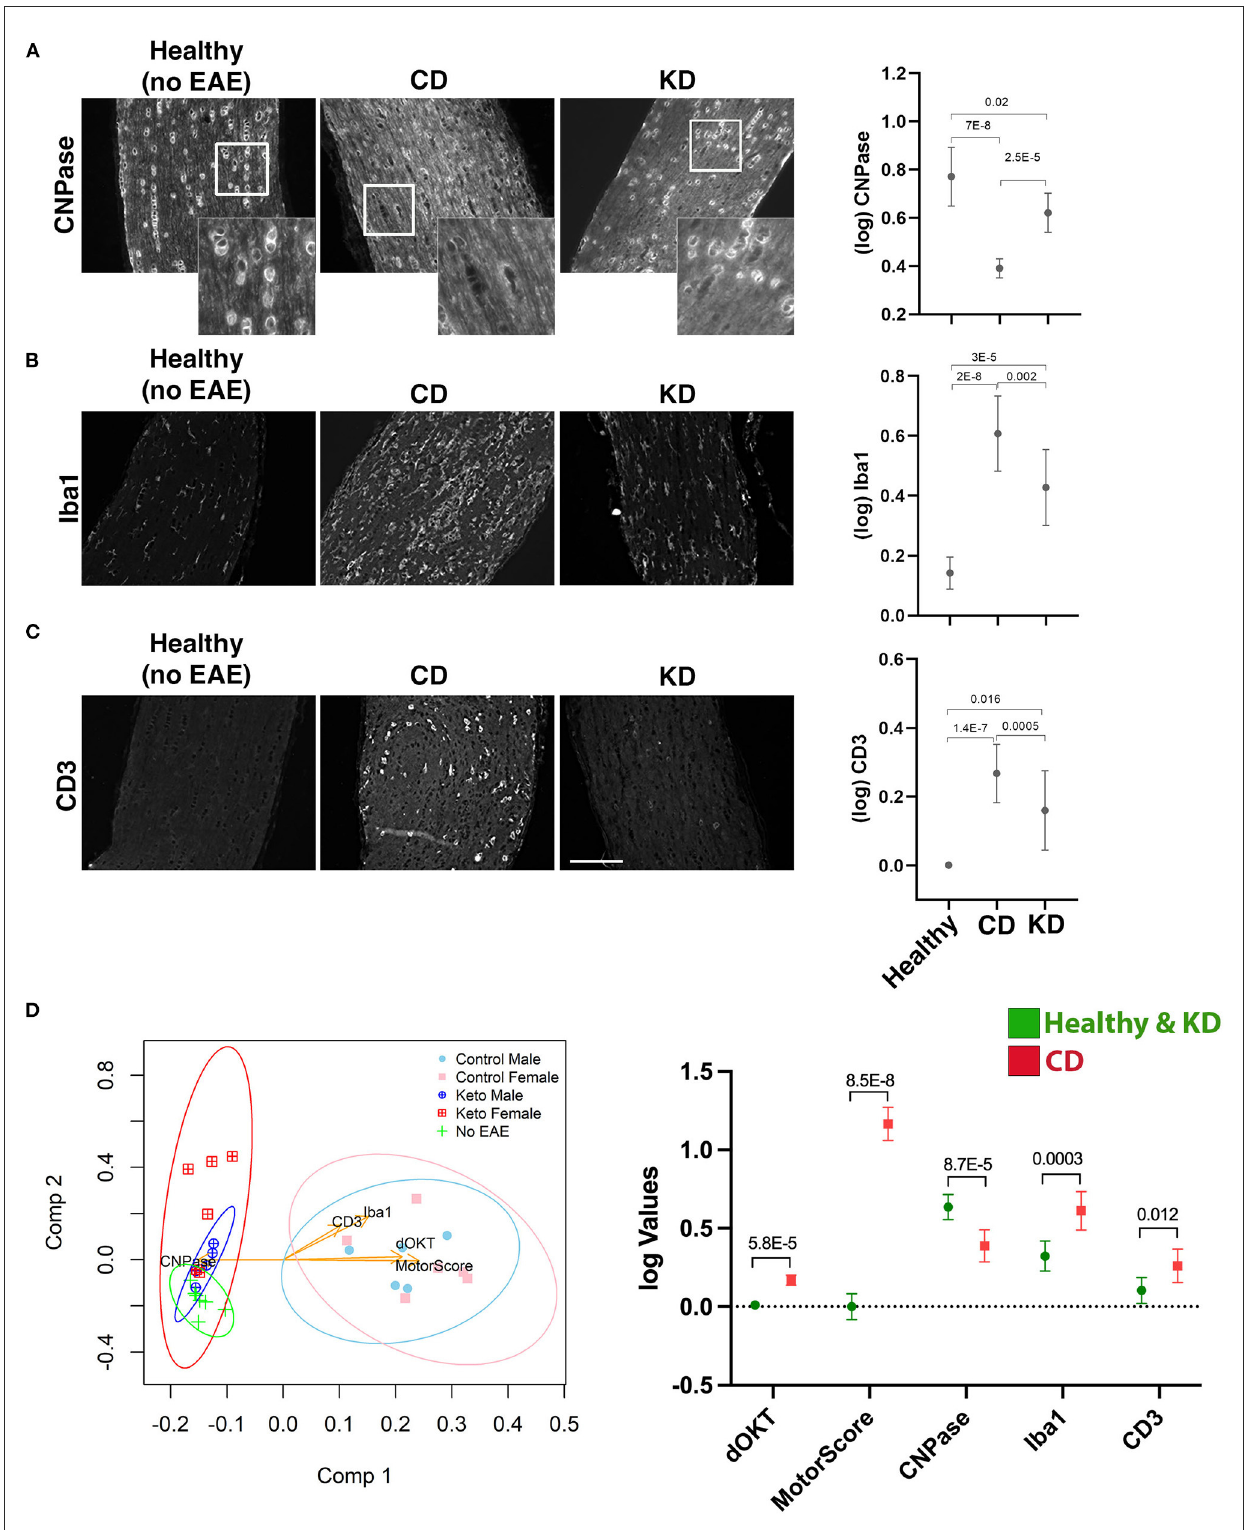
FIGURE4 The KD preserves oligodendrocytes on the optic nerve and reduces immune cell infiltrates. (A–C) Representative photomicrographs of paraffin-embedded optic nerve sections labeled for the indicated markers (CNPase, Iba1, and CD3, A–C respectively). Optic nerves from the MA eyes of EAE mice consuming the indicated diets and from healthy (no-EAE) mice on standard chow were compared. EAE MA optic nerves were taken from the mice analyzed functionally by OKT in Figure 3. Sections spanning the entire length of the optic nerve were labeled with each marker. Insets in (A) highlight the perinuclear CNPase labeling that was quantified. Mean values for CNPase, Iba1, and CD3 labeling of optic nerve sections are shown in the graphs to the right of the photomicrographs. Whisker bars depict 95% confidence intervals for each variable and horizontal bars